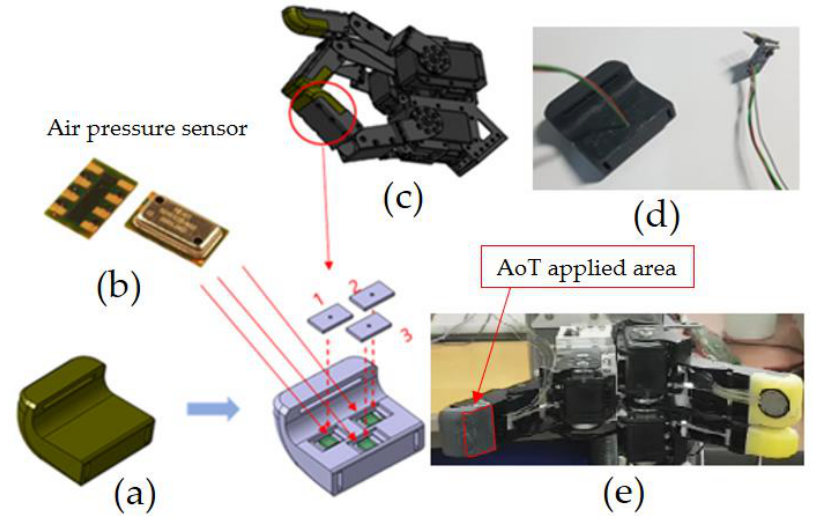
Figure 1. Configuration of tactile sensing module: ( a ) silicone base of the module, ( b ) air pressure sensor, ( c ) robot hand, ( d ) tactile sensing module, ( e ) module applied to robot hand.